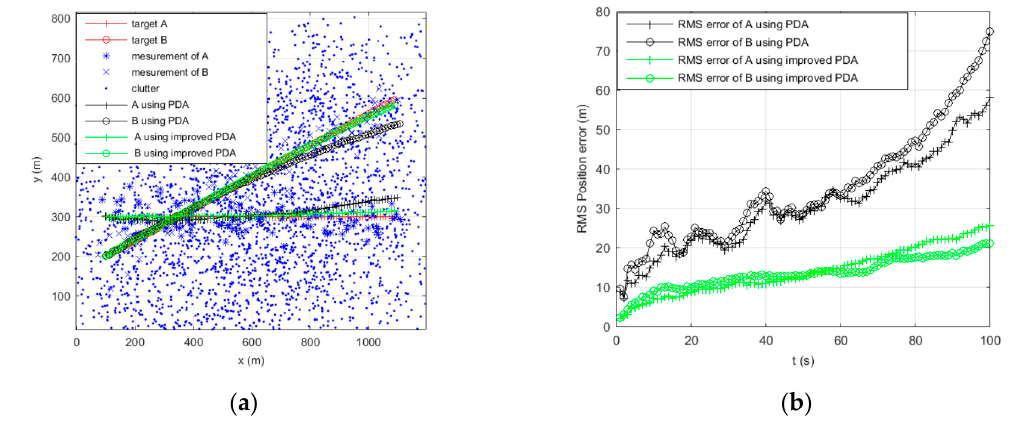
Figure 5. Tracking two crossing targets using PDA and improved PDA when clutter λ = 5. ( a ) Tracking of the target position; and ( b ) RMS position error of the target.